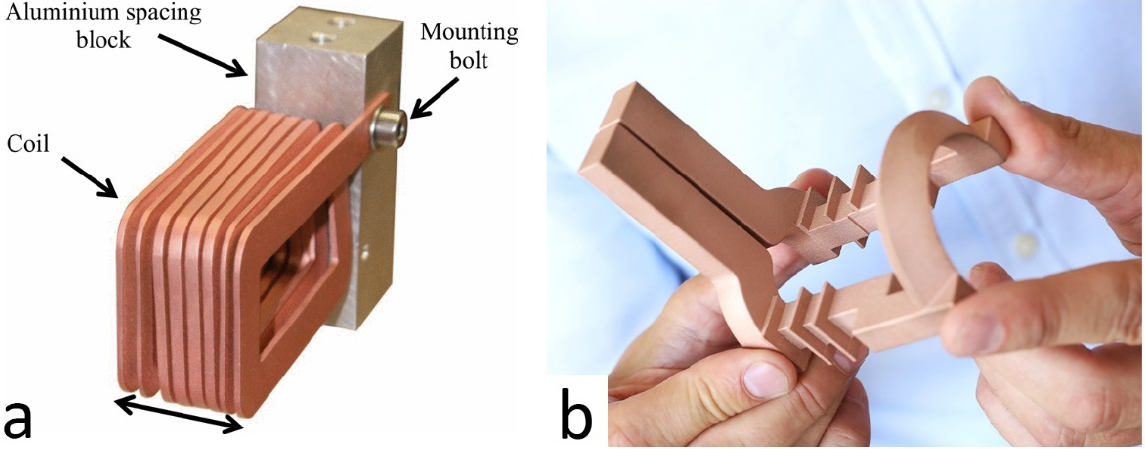
Figure 3. Additively manufactured ( a ) copper alloy windings [27] and ( b ) an induction heater with integrated water cooling [28].